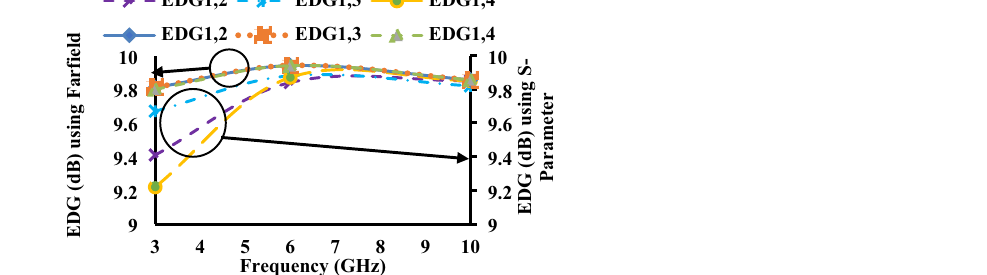
Figure 17. EDG of the proposed